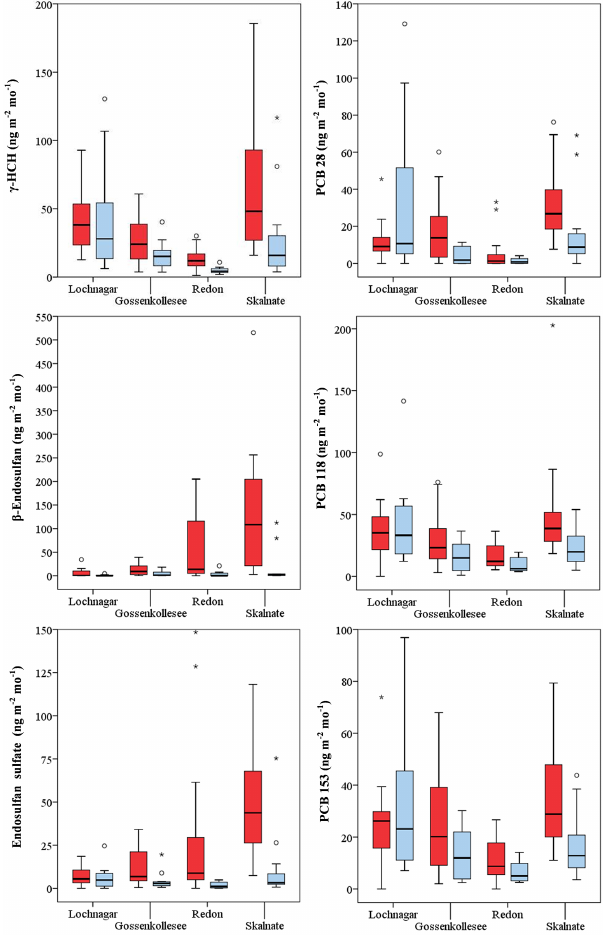
Figure 2. Boxplots of several OC deposition fluxes during warm (red) and cold (blue) seasons at the study sites. Horizontal lines rep- resent the median value. Atypical values (outside 1.5 times the in- terquartile range, IQR) are indicated by empty dots, while asterisks represent extreme values (outside 3 ×